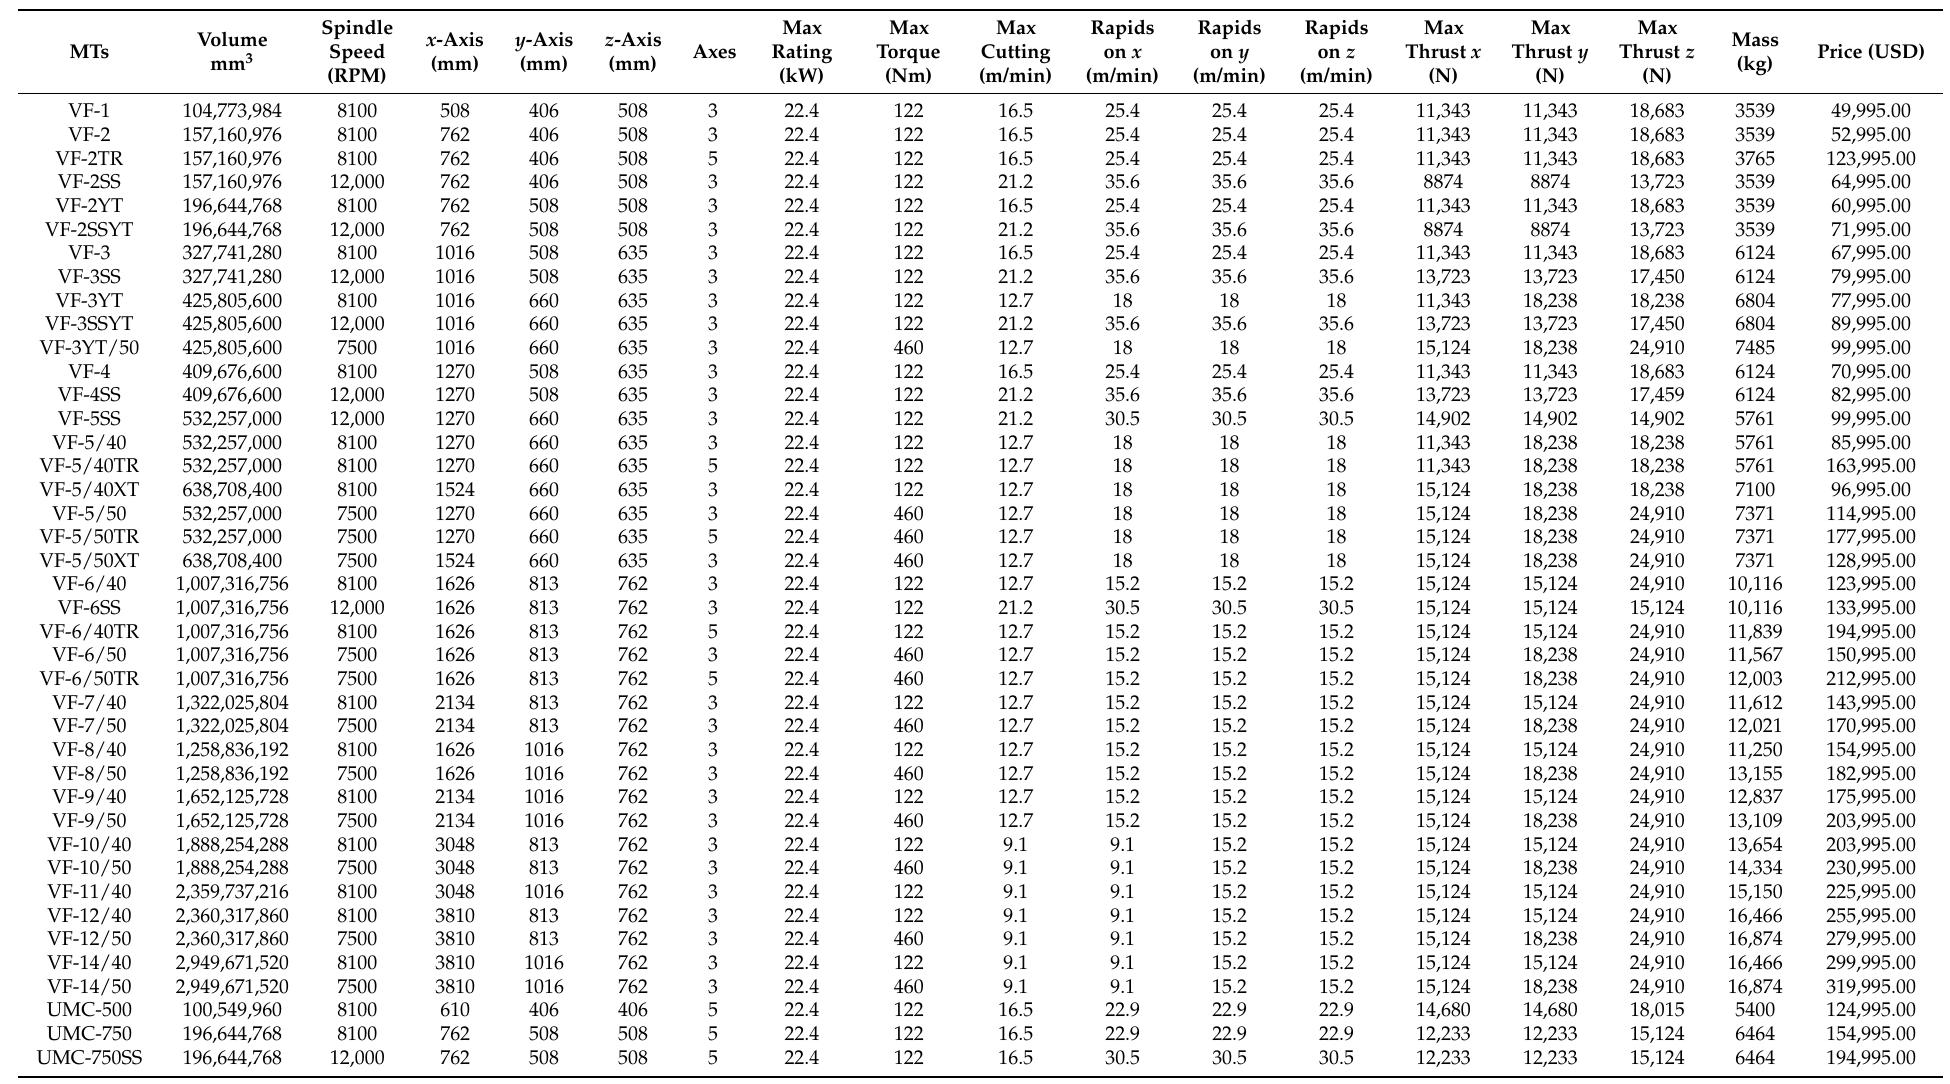
Table 1. Haas data (dataset